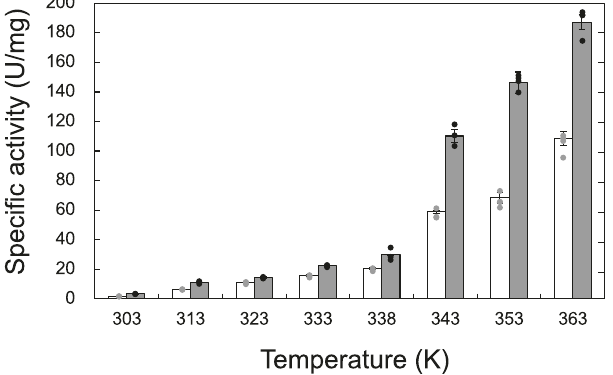
Fig. 3 Effect of temperature on enzyme activity. The activity of the immature (white bar) and mature enzymes (gray bar) were assayed in 100 mM tris (pH 8.0) at various temperatures. The length of the error bars represents the standard